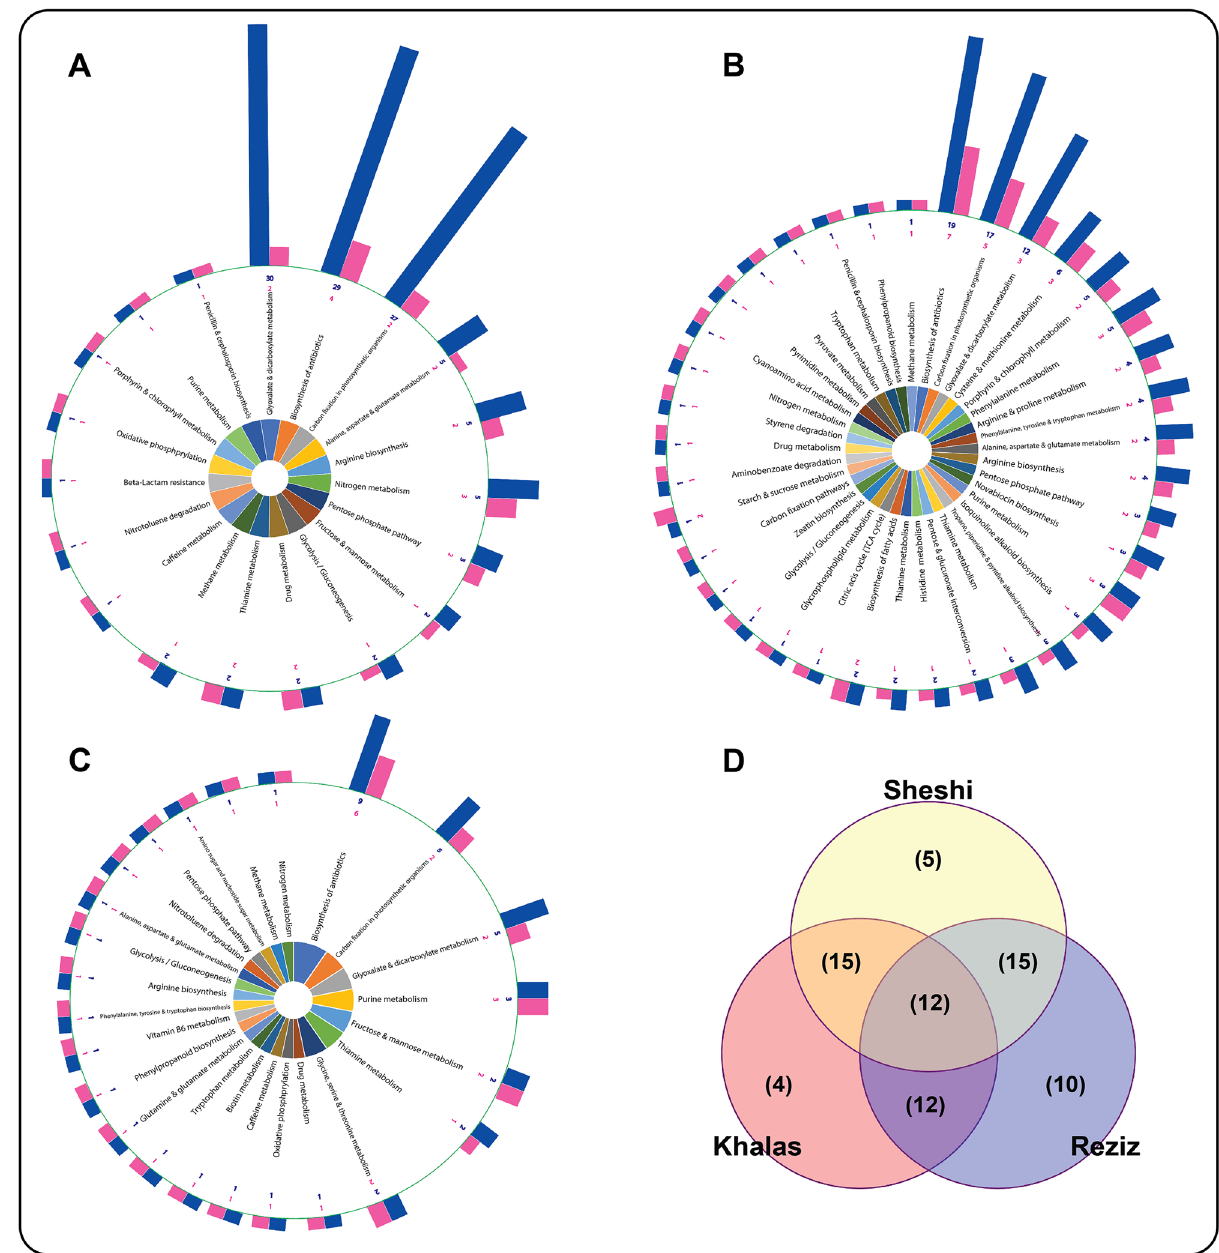
Figure 4. Pathways assigned to the drought-responsive ESTs in Khalas ( A ), Reziz ( B ), and Sheshi ( C ), after the elucidation of their KEGG pathways. The graph’s central part illustrates the pathways’ name; the outer shows the histogram, the number of enzymes (purple), and the number of genes encoding the enzymes (blue). The Venn diagram represents the number of common and unique pathways in three date palm cultivars ( D